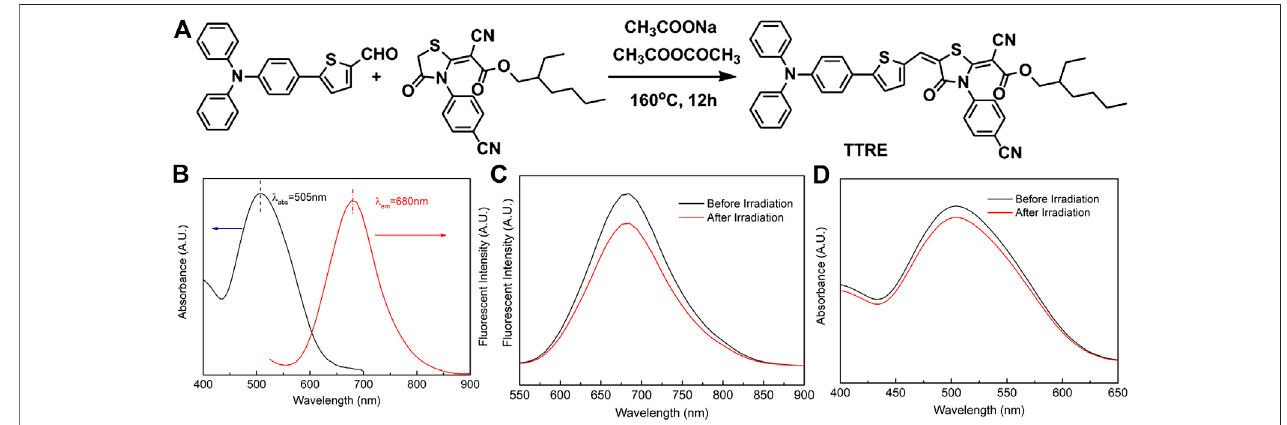
FIGURE 1 | (A) The synthetic routine of TTRE. (B) The Normalized absorption and fl uorescent spectra of TTRE in Water. (C) Fluorescent spectra of TTRE after irradiation (300mW/cm 2 ). (D) UV spectra of TTRE after irradiation (300mW/cm 2